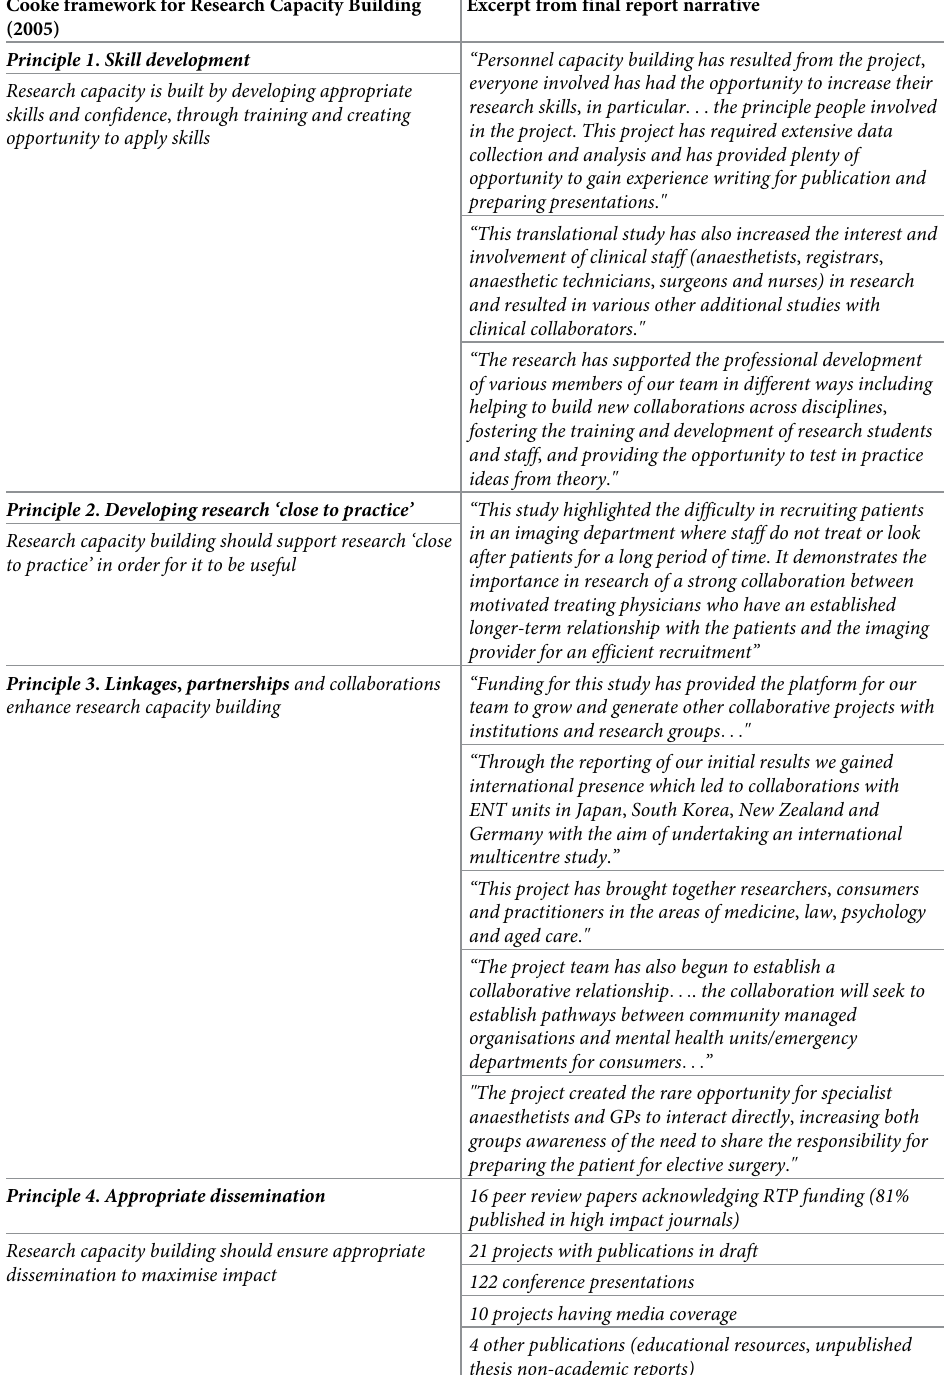
Table 3. Illustrative quotes of capacity building resulting from the RTP